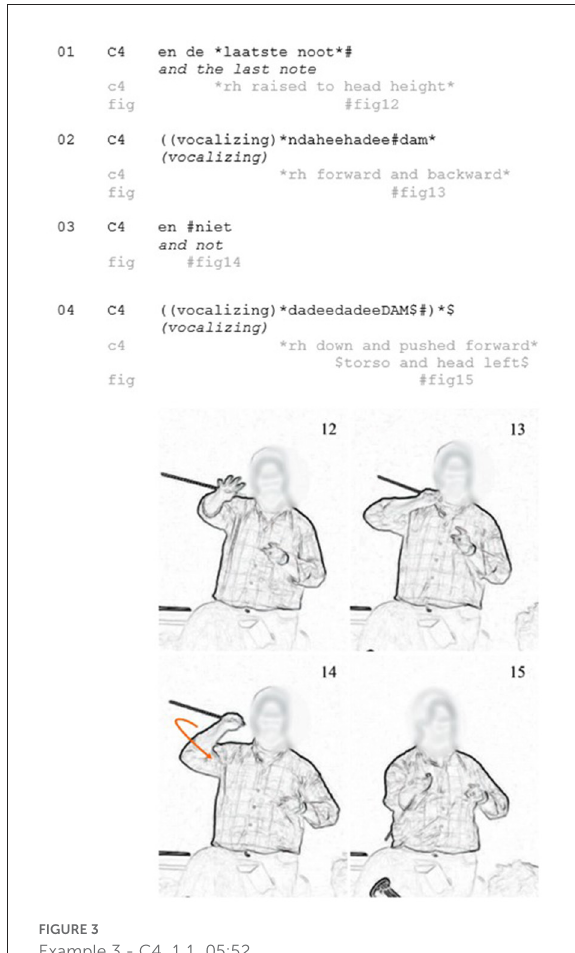
FIGURE3 Example 3 - C4_1.1_05:52.